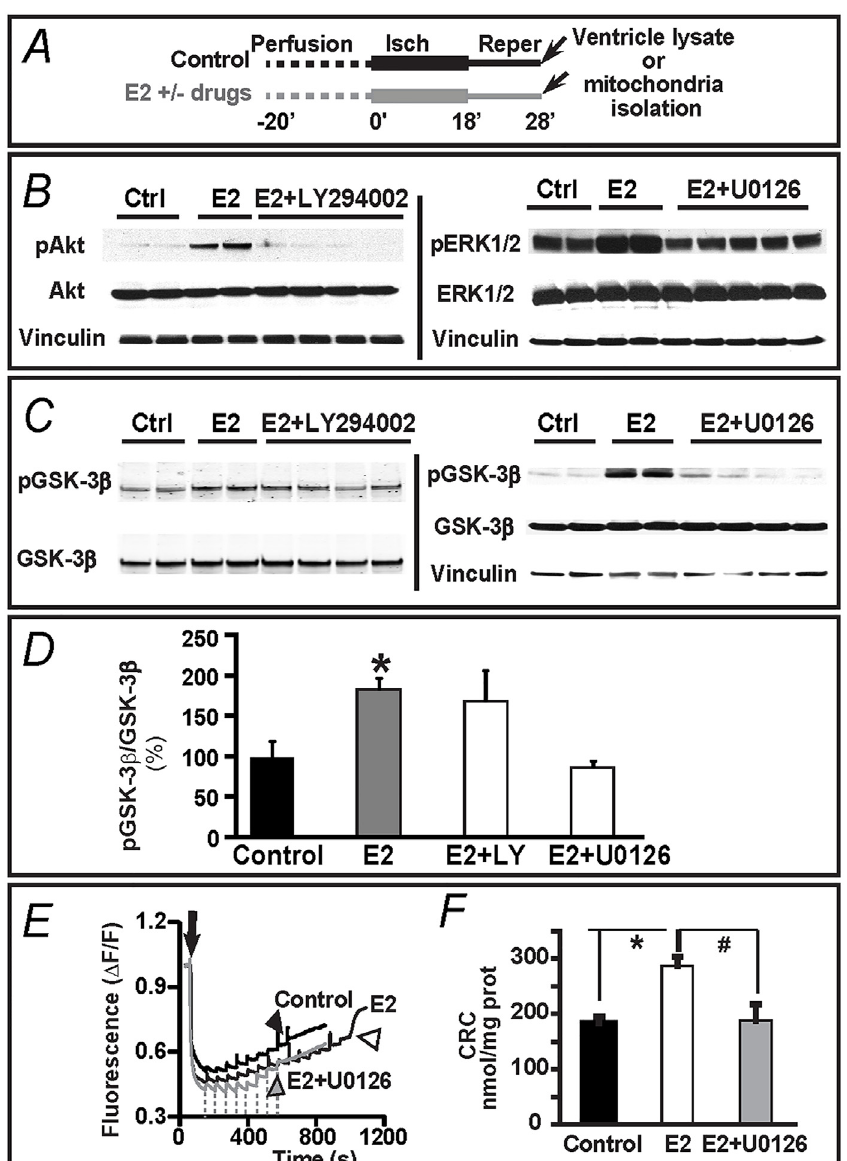
Fig 7. MEK 1/2 /ERK 1/2 – but not PI-3K/Akt- signaling supports E2-mediated protection from I/R via GSK- 3 β and mPTP. A. I/R protocol. Arrows mark the time of sample preparation. B. Immunoblots show that addition of the inhibitor of MEK 1/2 /ERK 1,2 pathway, U0126 (1 μ M) abolishes E2-induced up-regulation of pERK and the inhibitor of PI3-K/Akt pathway, LY294002 (10 μ M) abolishes the increase in pAkt induced by 40 nM E2. C,D. Immunoblots and corresponding bar graphs show that the inhibitor of MEK 1/2 /ERK 1,2 pathway, U0126 (1 μ M)-but not the inhibitor of PI3-K/Akt pathway, LY294002 (10 μ M)- abolishes the increase in pGSK-3 β /GSK-3 β ratio induced by 40 nM E2. E. Calcium load measurements were as indicated in Fig 5. Arrow, addition of mitochondria. Arrowheads, mark the massive Ca 2+ release (an index of mPTP opening) in mitochondria from control (black), E2 (40 nM)-treated (open), and treated with E2 (40 nM) + U0126 (1 μ M) (grey) hearts. Dashed lines mark the time of Ca 2+ addition to the E2+U0126 treated sample. F. Mean values of calcium retention capacity (CRC) demonstrate that 1 μ M U0126 prevents the beneficial effect of 40 nM E2. Note that vinculin was used as a loading housekeeping protein. All values were obtained from WT male mice and expressed as mean ± SEM; * P < 0.05 E2-treated group versus control; and # P < 0.05 E2+U0126 versus E2-treated group (n = 5 – 7